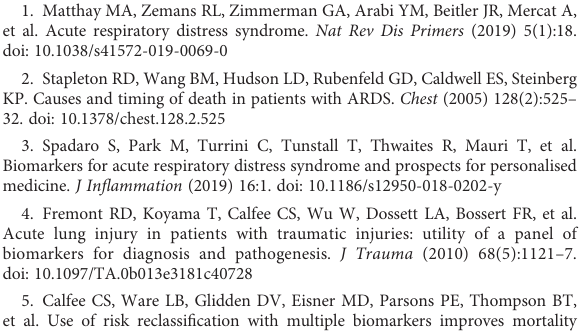
SUPPLEMENTARY FIGURE 4 ROC curve showing the discriminatory capacity of the nomogram in predicting 60-day mortality for septic